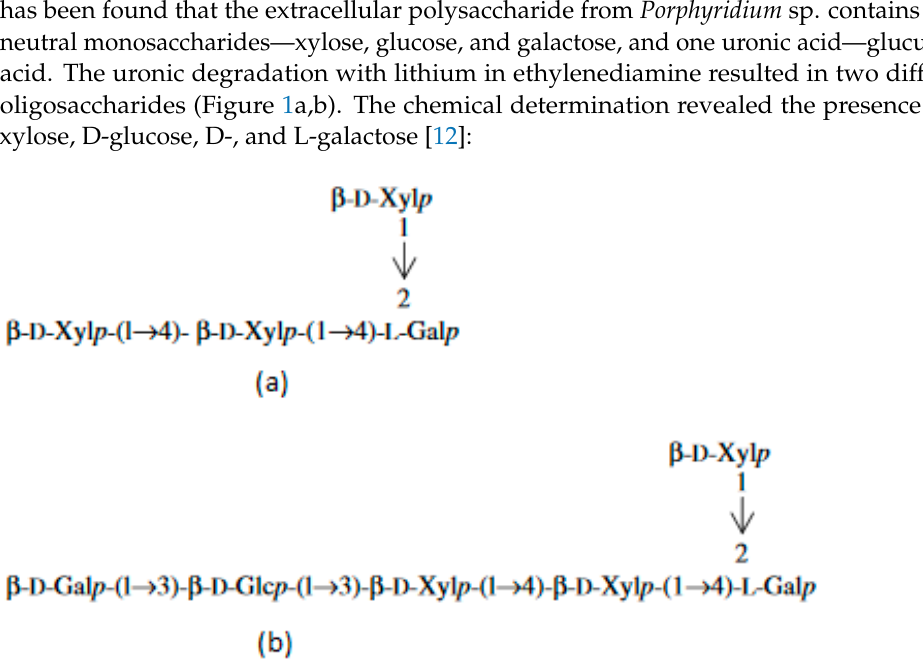
Figure 1. Oligosaccharides released from the extracellular polysaccharide of Porphyridium sp. after the uronic degradation with lithium in ethylenediamine. ( a )oligosaccharide 1; ( b ) oligosaccharide 2. All the red microalgae show a remarkable adaptation capacity to strong acid media (pH = 0.5–3.5) and high temperatures (38–56 ◦ C) [13,14]. Such extremophile characteristics allow red algae to survive in habitats which other organisms cannot tolerate. They are capable of persisting in different geothermal environments and sulfur springs, boiling mud pools, and hot acidic waters [15]. Moreover, red microalgae tolerate metals; thus, they can survive in rather toxic conditions